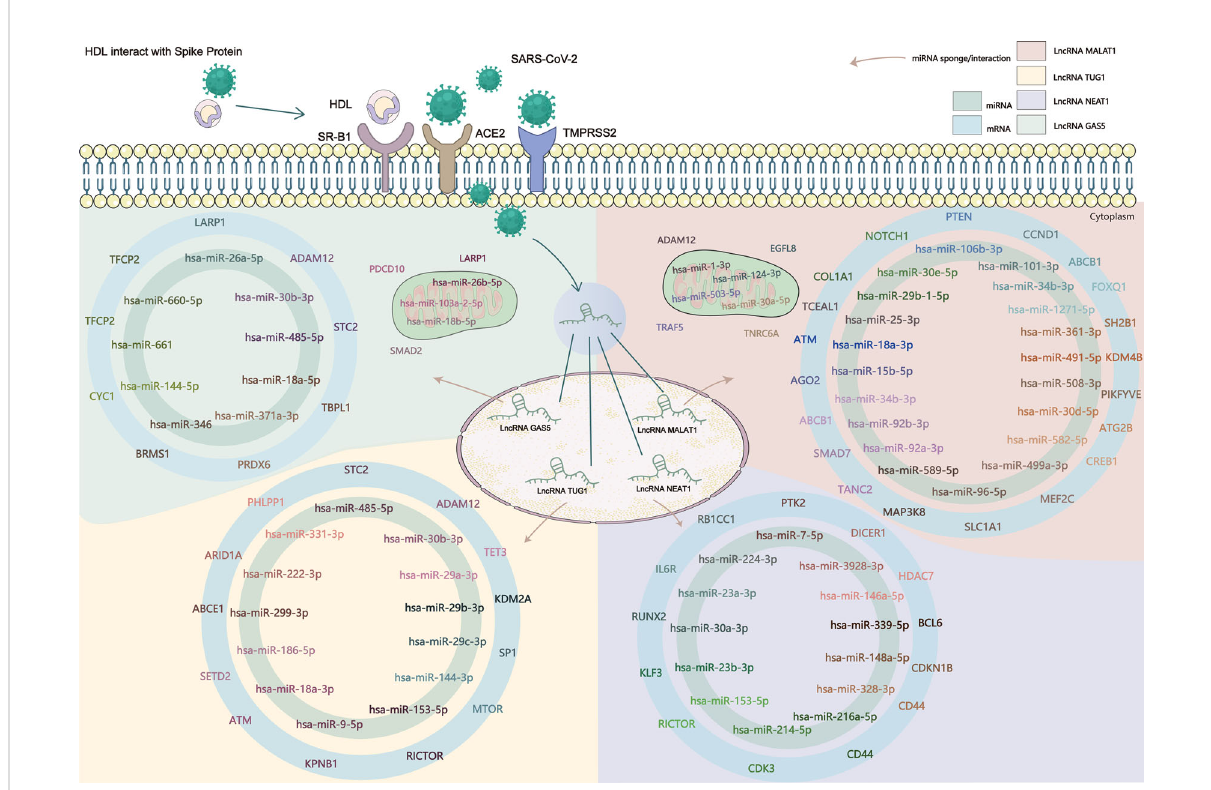
FIGURE 2 SARS-CoV-2 enters the human body through the ACE2 receptor, TMPRSS2, and SR-B1 co-receptors, affects the expression of lncRNA, and then affects the downstream gene targets through the ceRNA network constructed by lncRNA-miRNA-mRNA. The known lncRNA GAS5, lncRNA MALAT1, lncRNA NEAT1, and lncRNA TUG1 are the therapeutic targets of COVID-19, and the predicted lncRNA-miRNA-mRNA network may provide new targets in the clinical treatment and drug development of